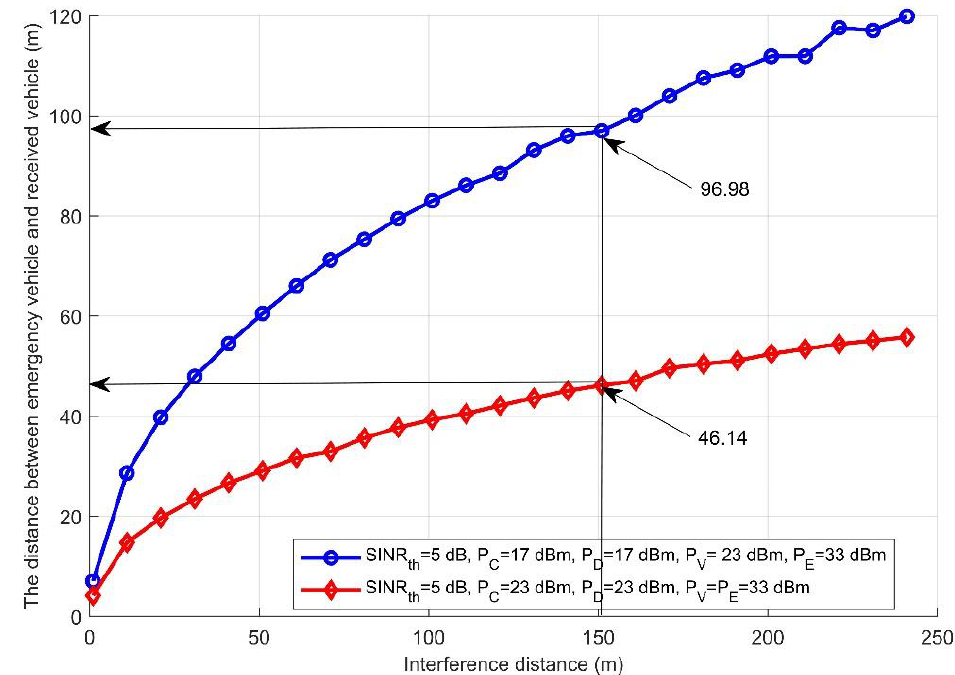
Figure 2. The distance between the emergency vehicle and the receiving vehicle versus interference distance.